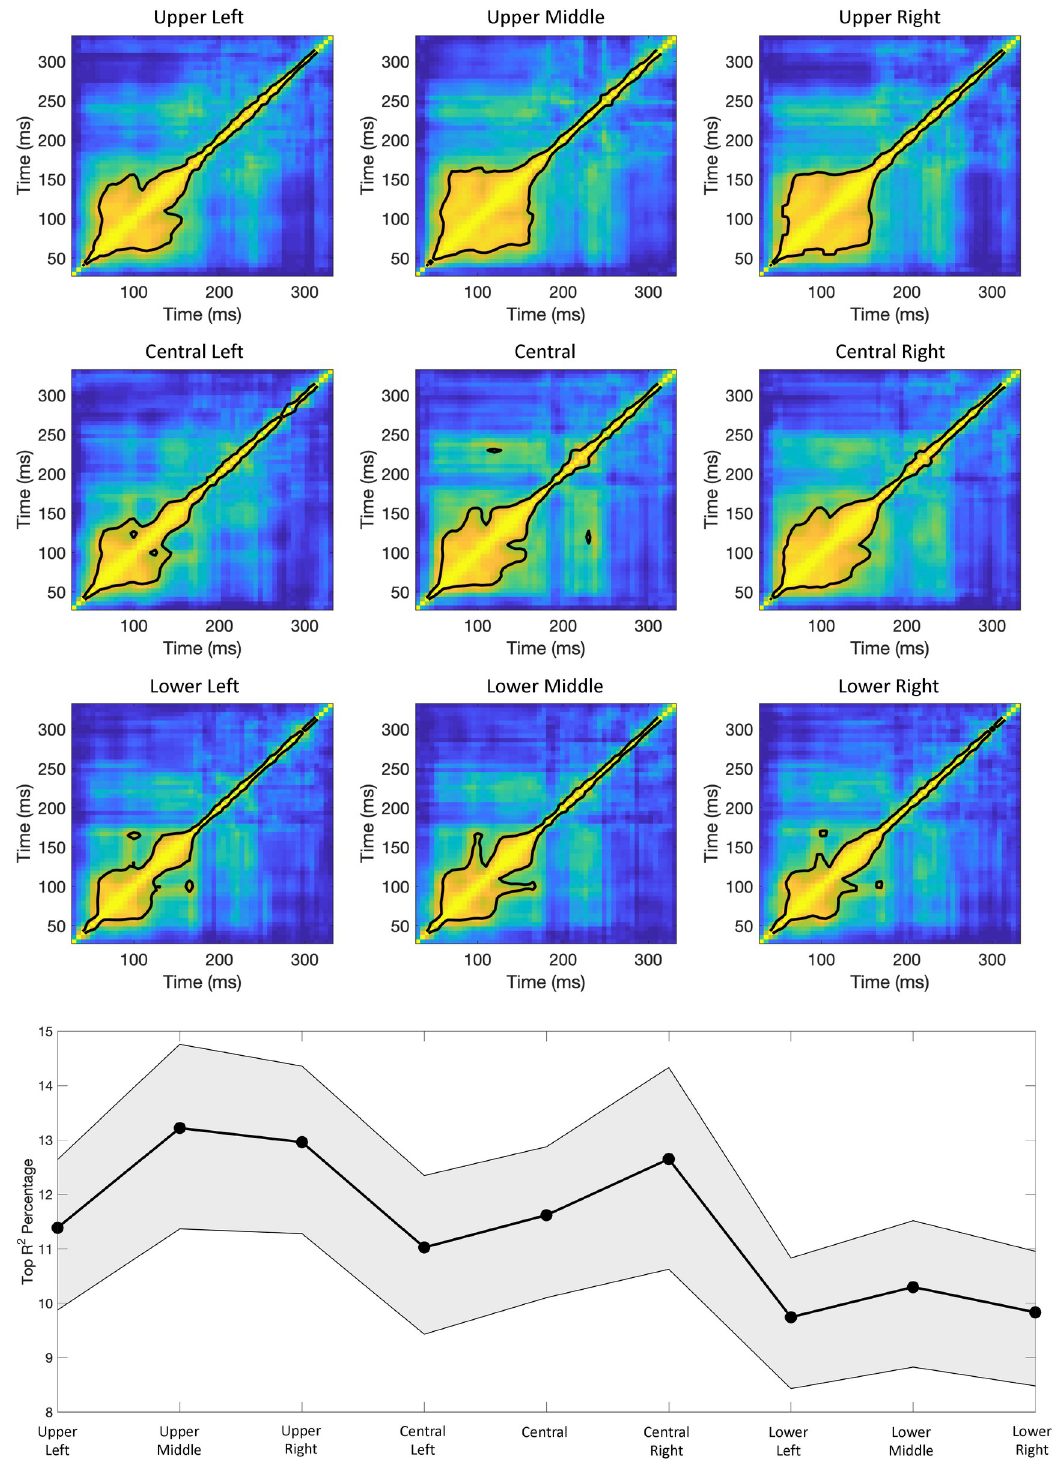
Fig 14. Top: Results from the time-time regression analysis on the participant averaged SF probability ratios within each of the nine local image windows. Bottom: The percentage of time-time R 2 s that fell within the top 12% contour area was calculated for each participant, and then averaged across participants (gray area shows the 95% confidence